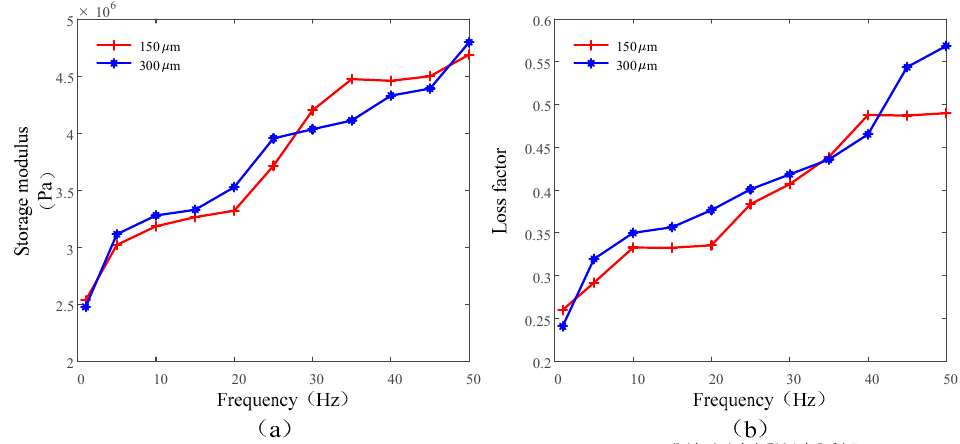
Figure 10. Dynamic parameters of specimen X01 vary with frequency: ( a ) storage modulus and ( b )